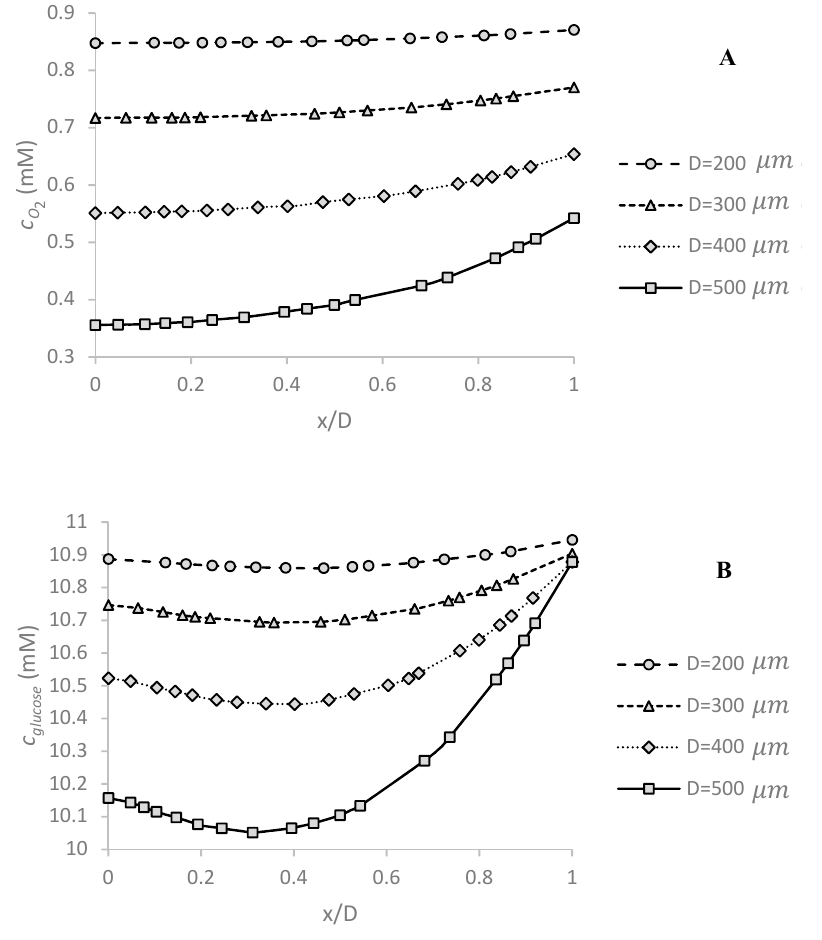
Figure 4. The effect of spheroid diameter D on ( A ) oxygen and ( B ) glucose concentration profiles in the center of spheroid along x -axis (function of dimensionless x position: x / D ). The maximum oxygen and glucose concentration difference in the spheroid increases, respectively from ~3% to ~52% and from ~1% to ~8% as the spheroid diameter increases from 200 µ m to 500 µ m. The simulations are done under Q = 5 µ L/min, c 0, O 2 = 0.2 mM and (cid:1855) (cid:2868),(cid:3034)(cid:3039)(cid:3048)(cid:3030)(cid:3042)(cid:3046)(cid:3032) = 11 mM .